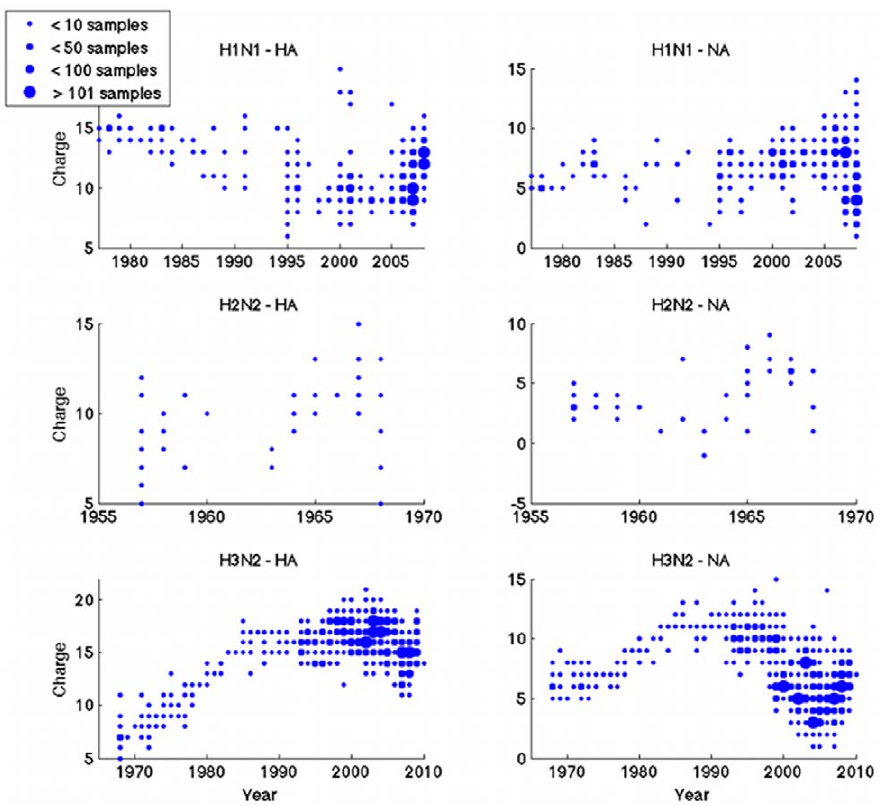
Figure 1. Timecourses of total charge of the major antigens HA and NA. Shown for three main human subtypes of influenza A. Sizes of dots represent frequencies, as indicated in the legend. Increase in positive charge for both H3N2 glycoproteins is statistically significant (p , 0.0001 in both